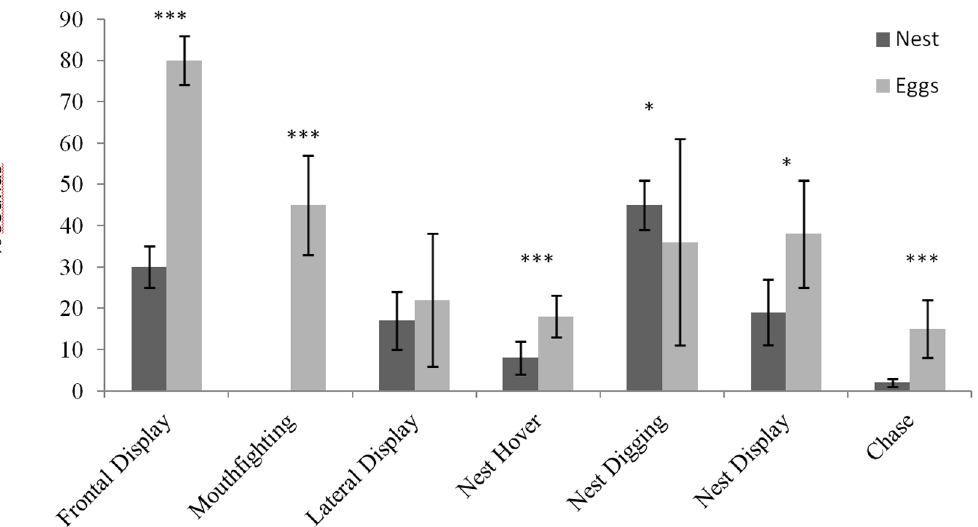
Figure 6. Mean percentage (% ± SE) of sound production during the display of different behaviours in Oreochromisniloticus females. Nest=territorial female; eggs=female incubating eggs. * p , 0.05, *** p , 0.001: significant differences between light and dark grey bars (Mann-Whithney test). The statistical test cannot be applied to Mouth fighting because this behaviour was not recorded during ‘‘Nest’’ experiments.